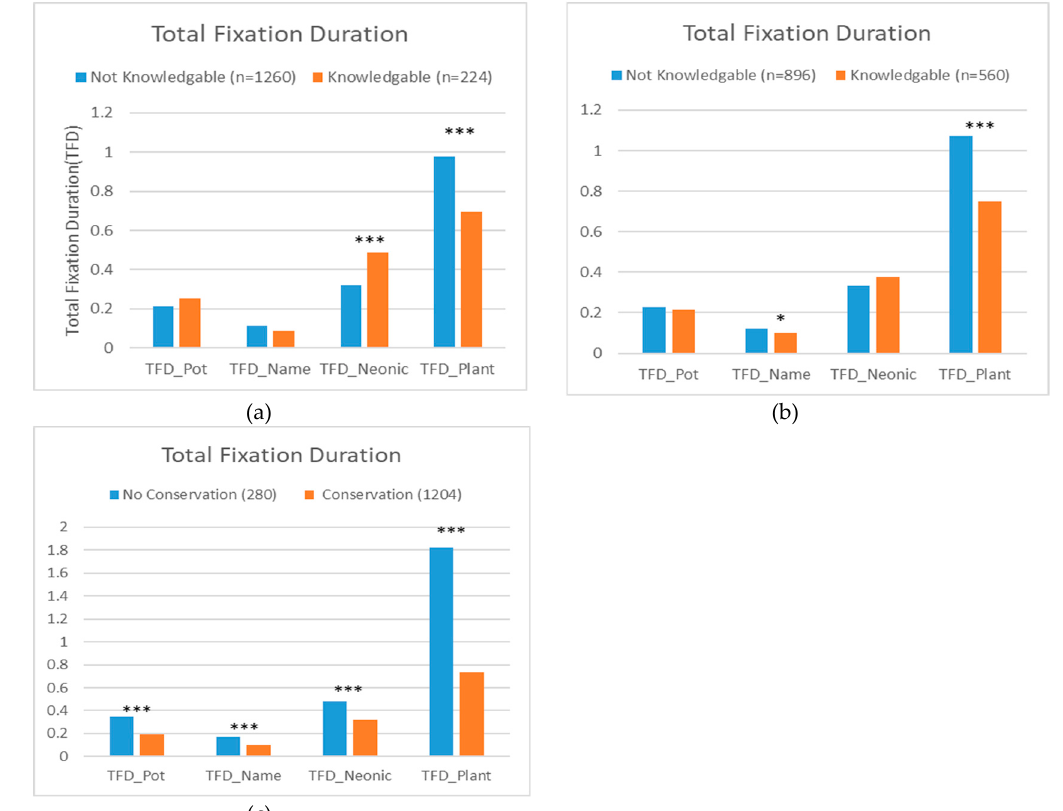
Figure A1. Total fixation duration patterns by di ff erent groups. ( a ) by perceived knowledge about neonicotinoids; ( b ) by knowledge about pollinator attractive plants; ( c ) by conservation activity. Notes: ***, ** and * indicates whether the mean di ff erence between participants in di ff erent groups are statistically significant (* p < 0.10; ** p < 0.05; and *** p < 0.01) based on a pairwise t -test. In Figure A1-a,